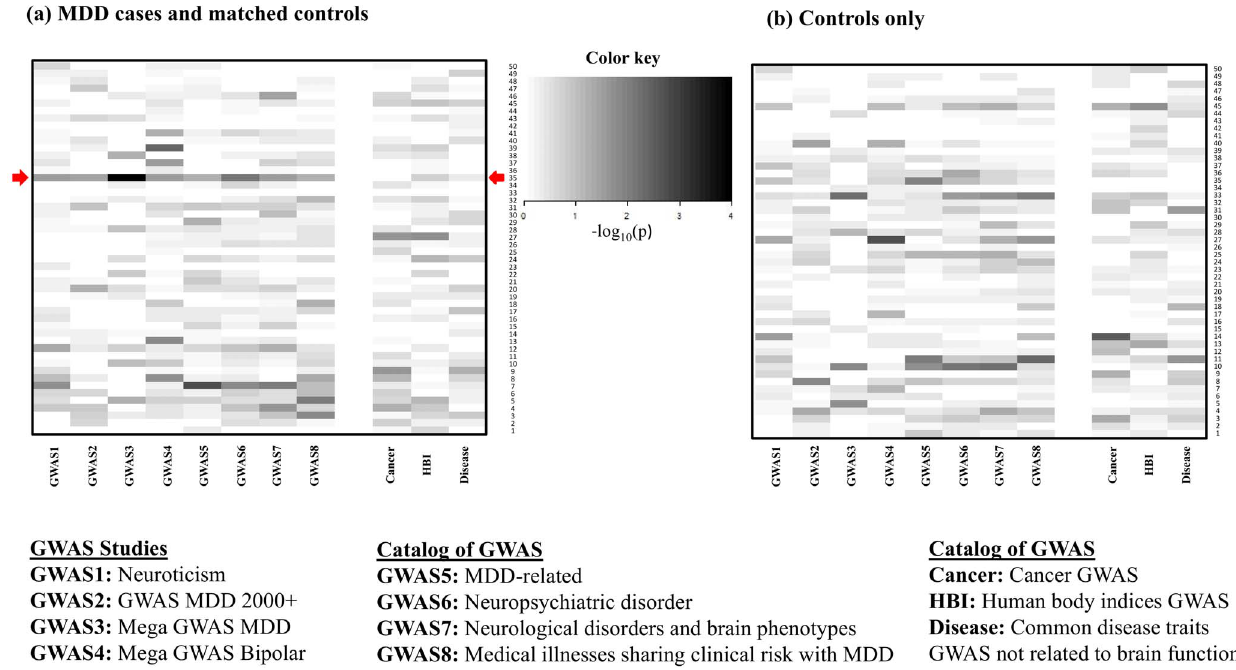
Figure 2. Consistent association of genes in module # 35 with MDD-related gene categories. ( a ) Heatmap of log 10 -transformed p-values from Fisher’s exact test for 50 modules obtained from MDD cases and matched controls and 8 MDD related GWAS and 3 negative controls. ( b ) Heatmap of log 10 -transformed p-values from Fisher’s exact test for 50 modules obtained from controls and 8 MDD related GWAS and 3 negative controls. The green rectangle identifies module # 35.